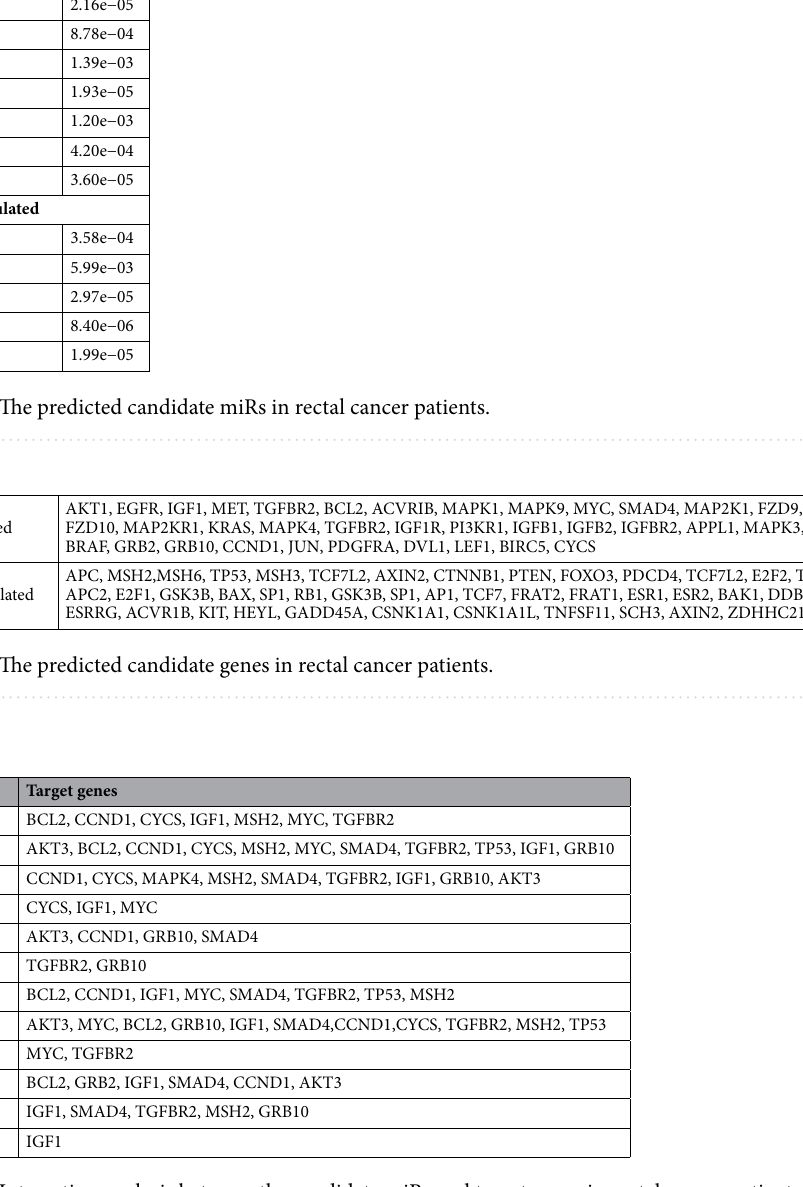
Table 3. Interaction analysis between the candidate miRs and target genes in rectal cancer